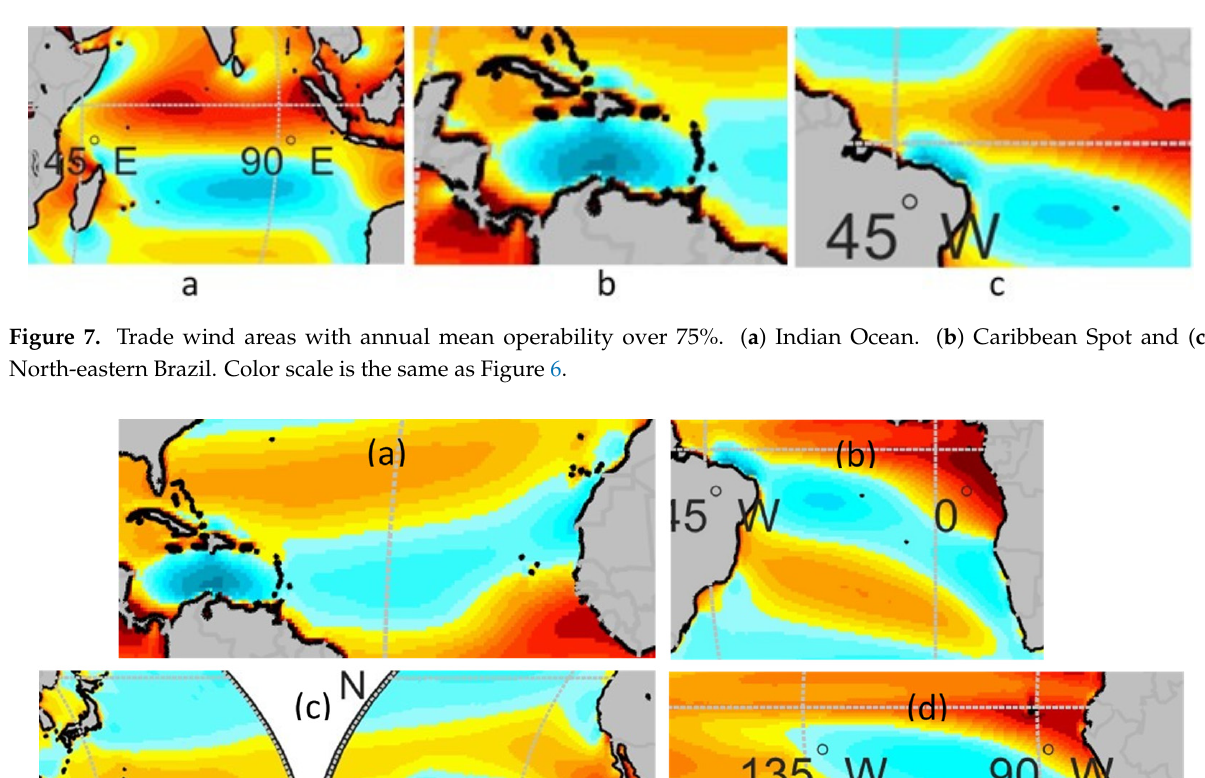
ure 7a. Color scale the same as Figure 6.